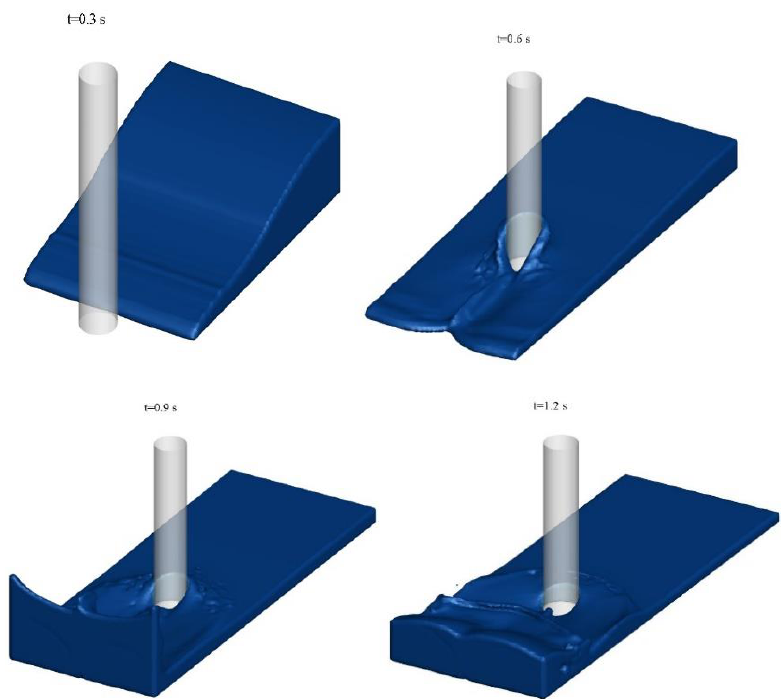
Figure 10. Simulation of the 3D dam-break flows over a vertical circular